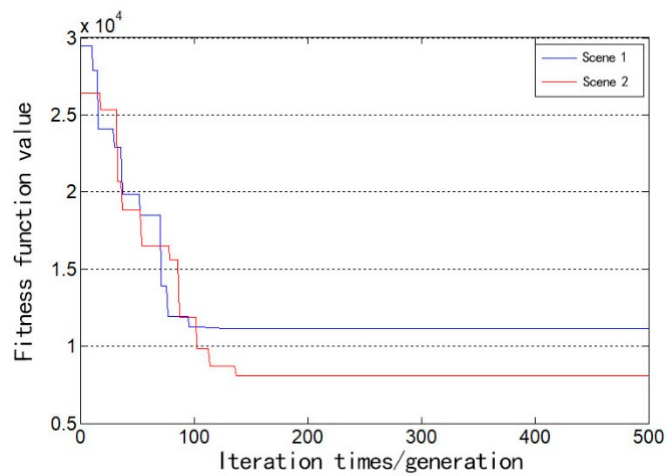
Figure 5. Scenario 1 and scenario 2 convergence curves of the NSGA-II multiobjective function solving